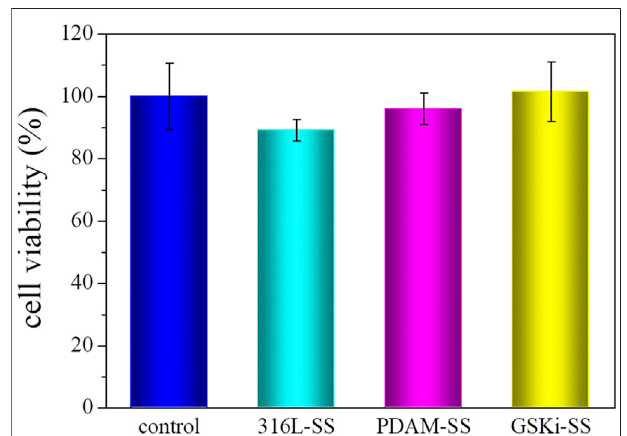
FIGURE 6 | HCAEC viability after incubation with 316L-SS, PDAM-SS and GSKi-SS for 24 h.